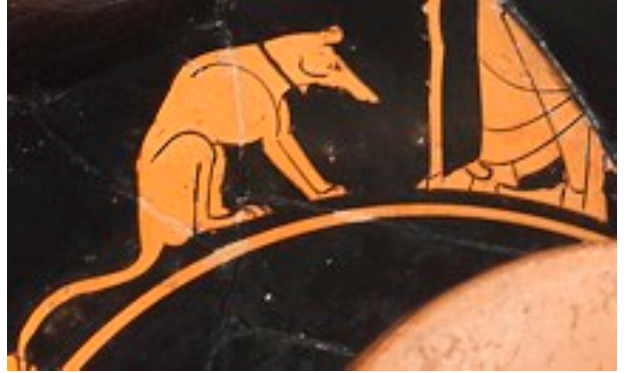
Figure 21. Detail of Figure 20.